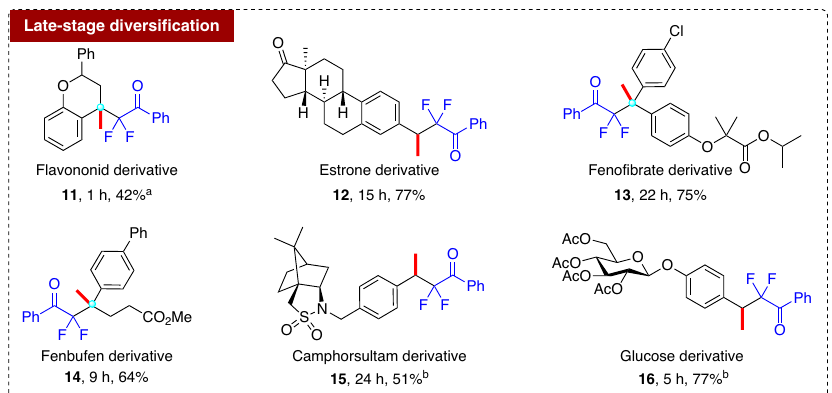
Fig. 5 Late-stage hydrodi fl uoroalkylation of natural products and drug derivatives. Reaction conditions: alkenes (0.3 mmol), 2a (0.45 mmol), Mg (ClO 4 ) 2 ‧ 6H 2 O (10 mol%), and ClCH 2 CH 2 Cl (3 mL) in air at room temperature. a In all, 3 mol% Mg(ClO 4 ) 2 ‧ 6H 2 O, 3 equiv. 2a . b In all, 20 mol% Mg(ClO 4 ) 2 ‧ 6H 2 O, 3 equiv. 2a .